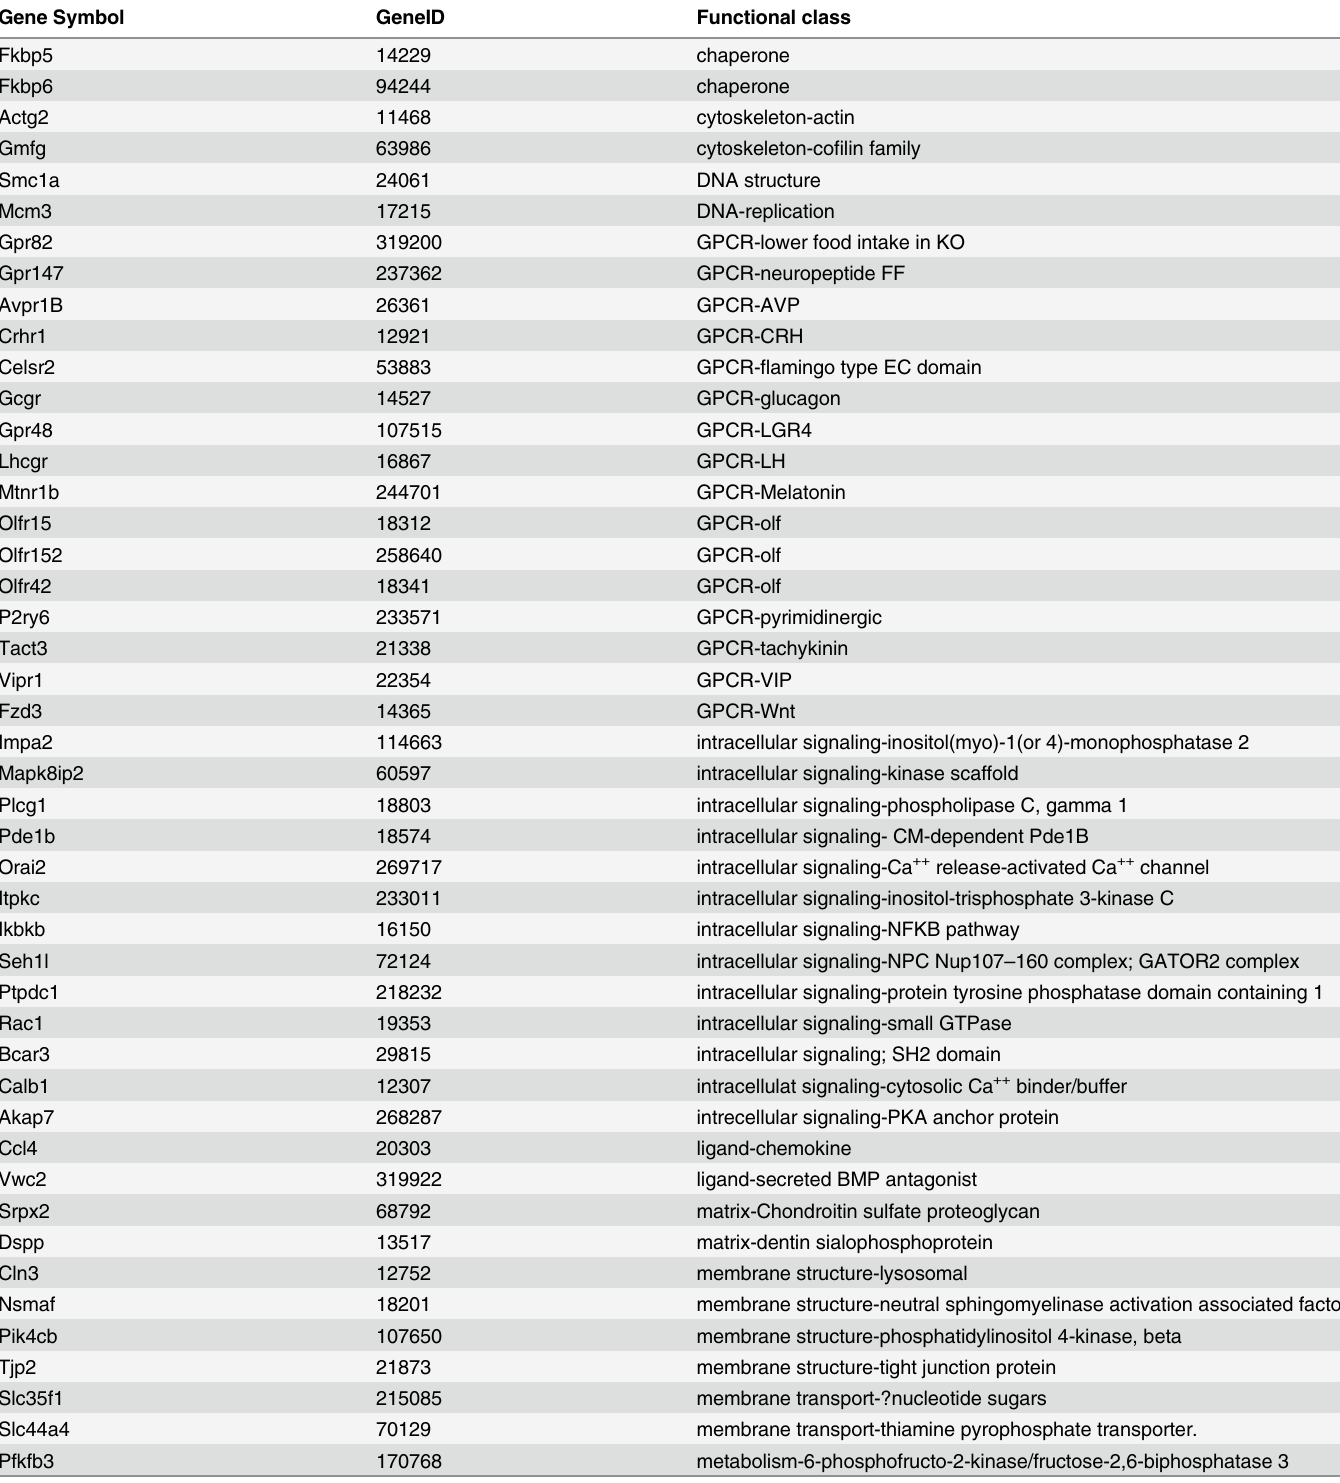
Table 2. Genes in Tsc1 null MEFs scoring positive in one of three